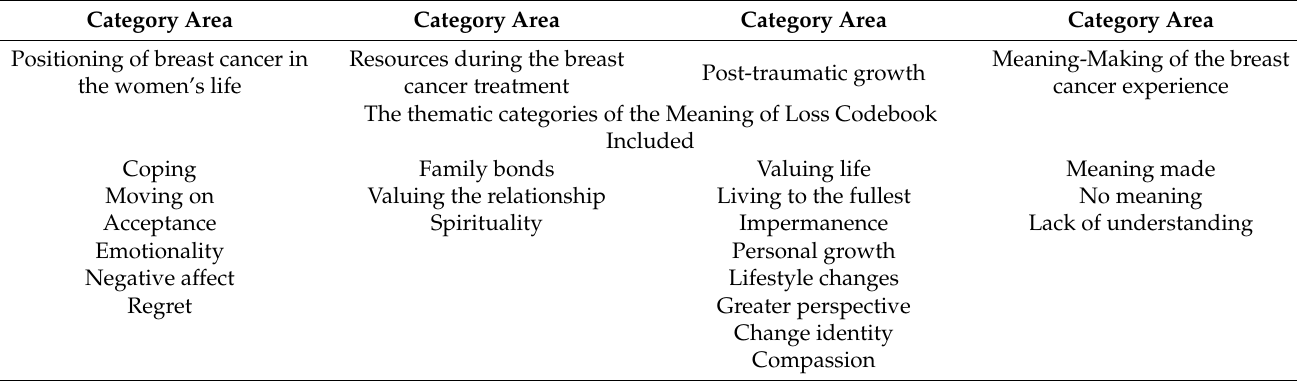
Table 2. Categories area and thematic categories of